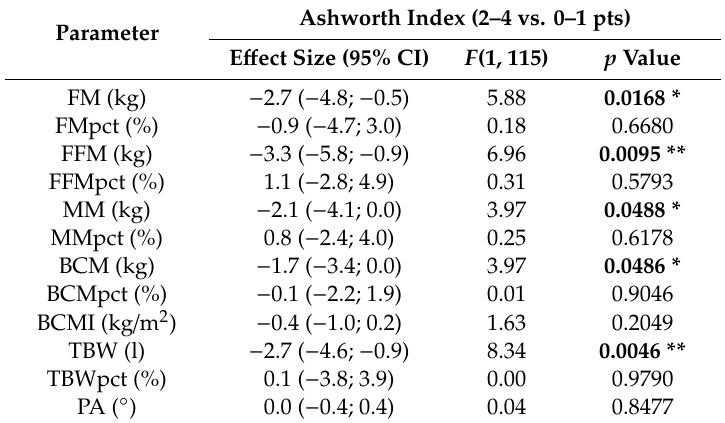
Table 4. Selected components of body composition in the children with CP relative to muscle tone level according to Ashworth scale.